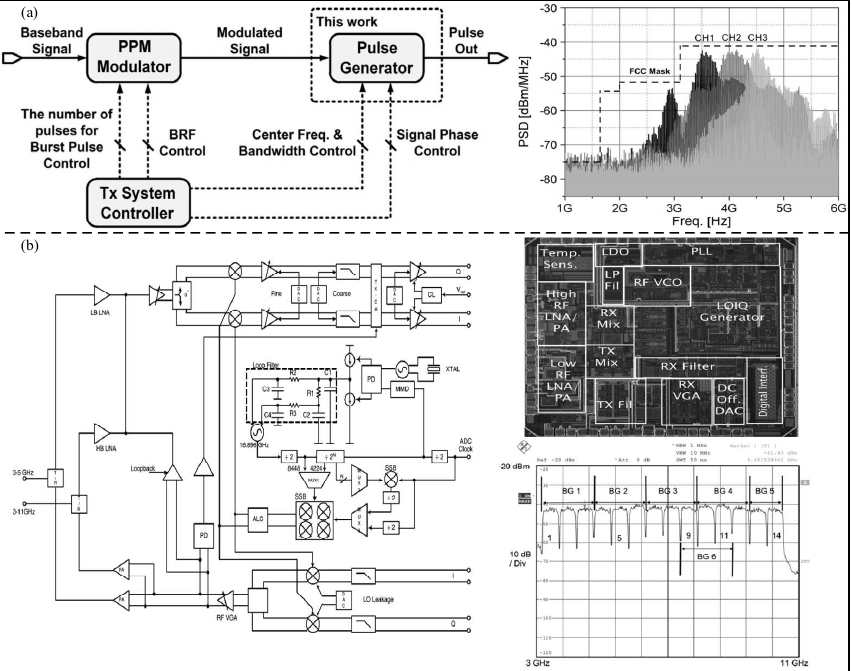
Figure 6. ( a ) System configuration for UWB transmission and measured output for each channel. (Reprinted from [42], Copyright 2012, with permission from IEEE). ( b ) Block diagram and chip mi- crophotograph of the UWB transceiver, and the measured spectrum of all 14 channels. (Reprinted from [44], Copyright 2007, with permission from